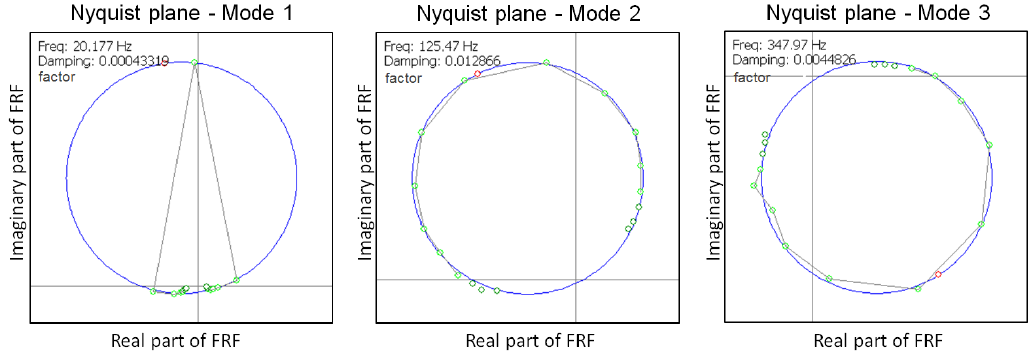
Figure 3. Circle fit method application to the three resonances of the cantilever beam.